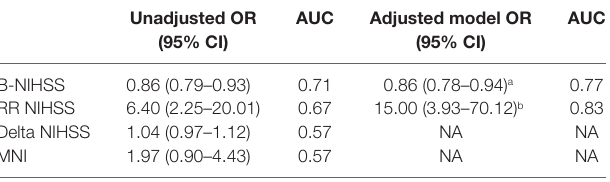
TaBle 3 | Logistic regression analysis for GFO in patients with mild to severe stroke patients ( n = 131).